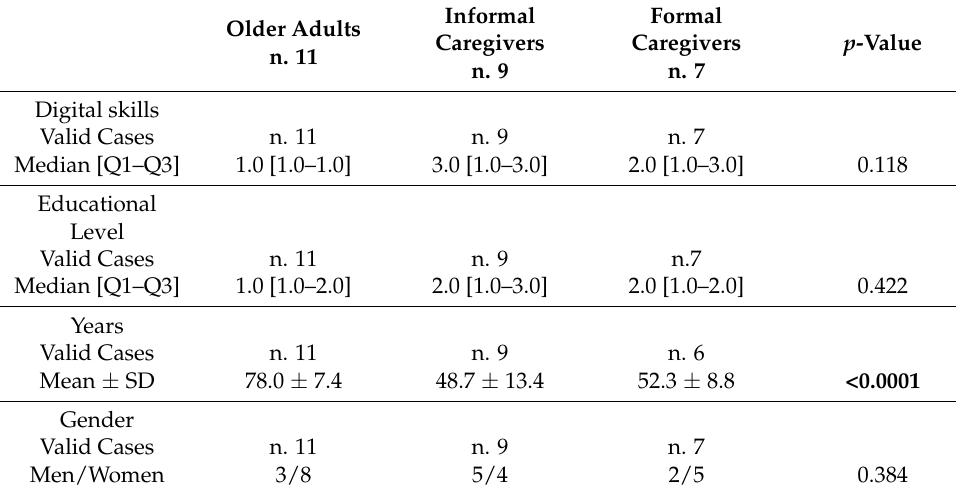
Table 8. General overview of participants in pre-validation Phase 2.